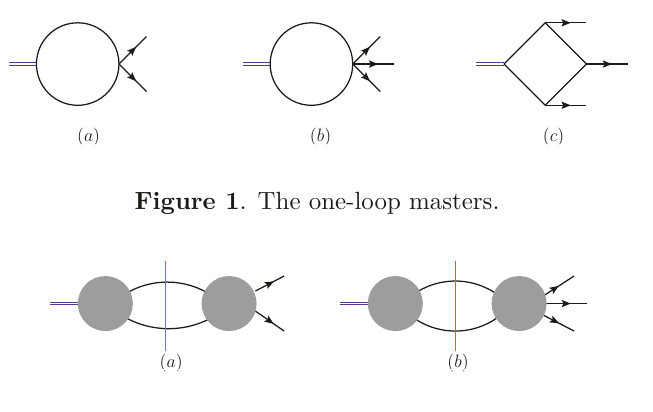
Figure 2 . The one-loop cuts.